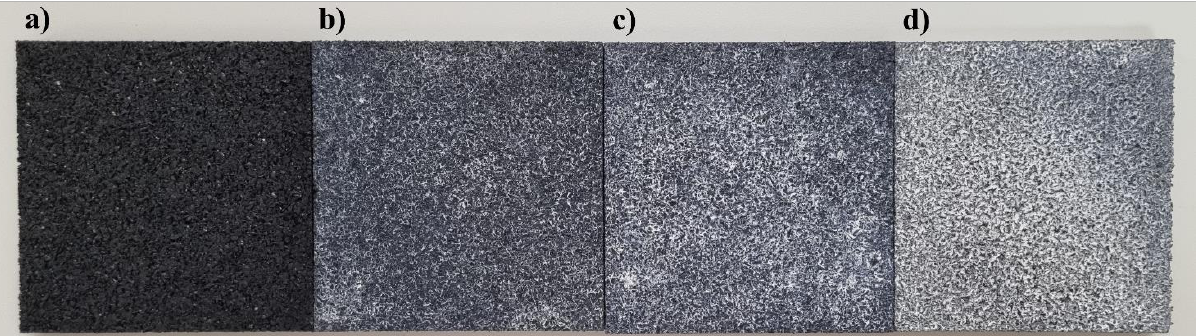
Figure 6. Surface comparison of referent rubber with sol – gel immobilized substrates: ( a ) referent substrate, ( b ) substrate with 2 g of TiO 2 , ( c ) substrate with 4 g of TiO 2 , and ( d ) substrate with 10 g of TiO 2 .